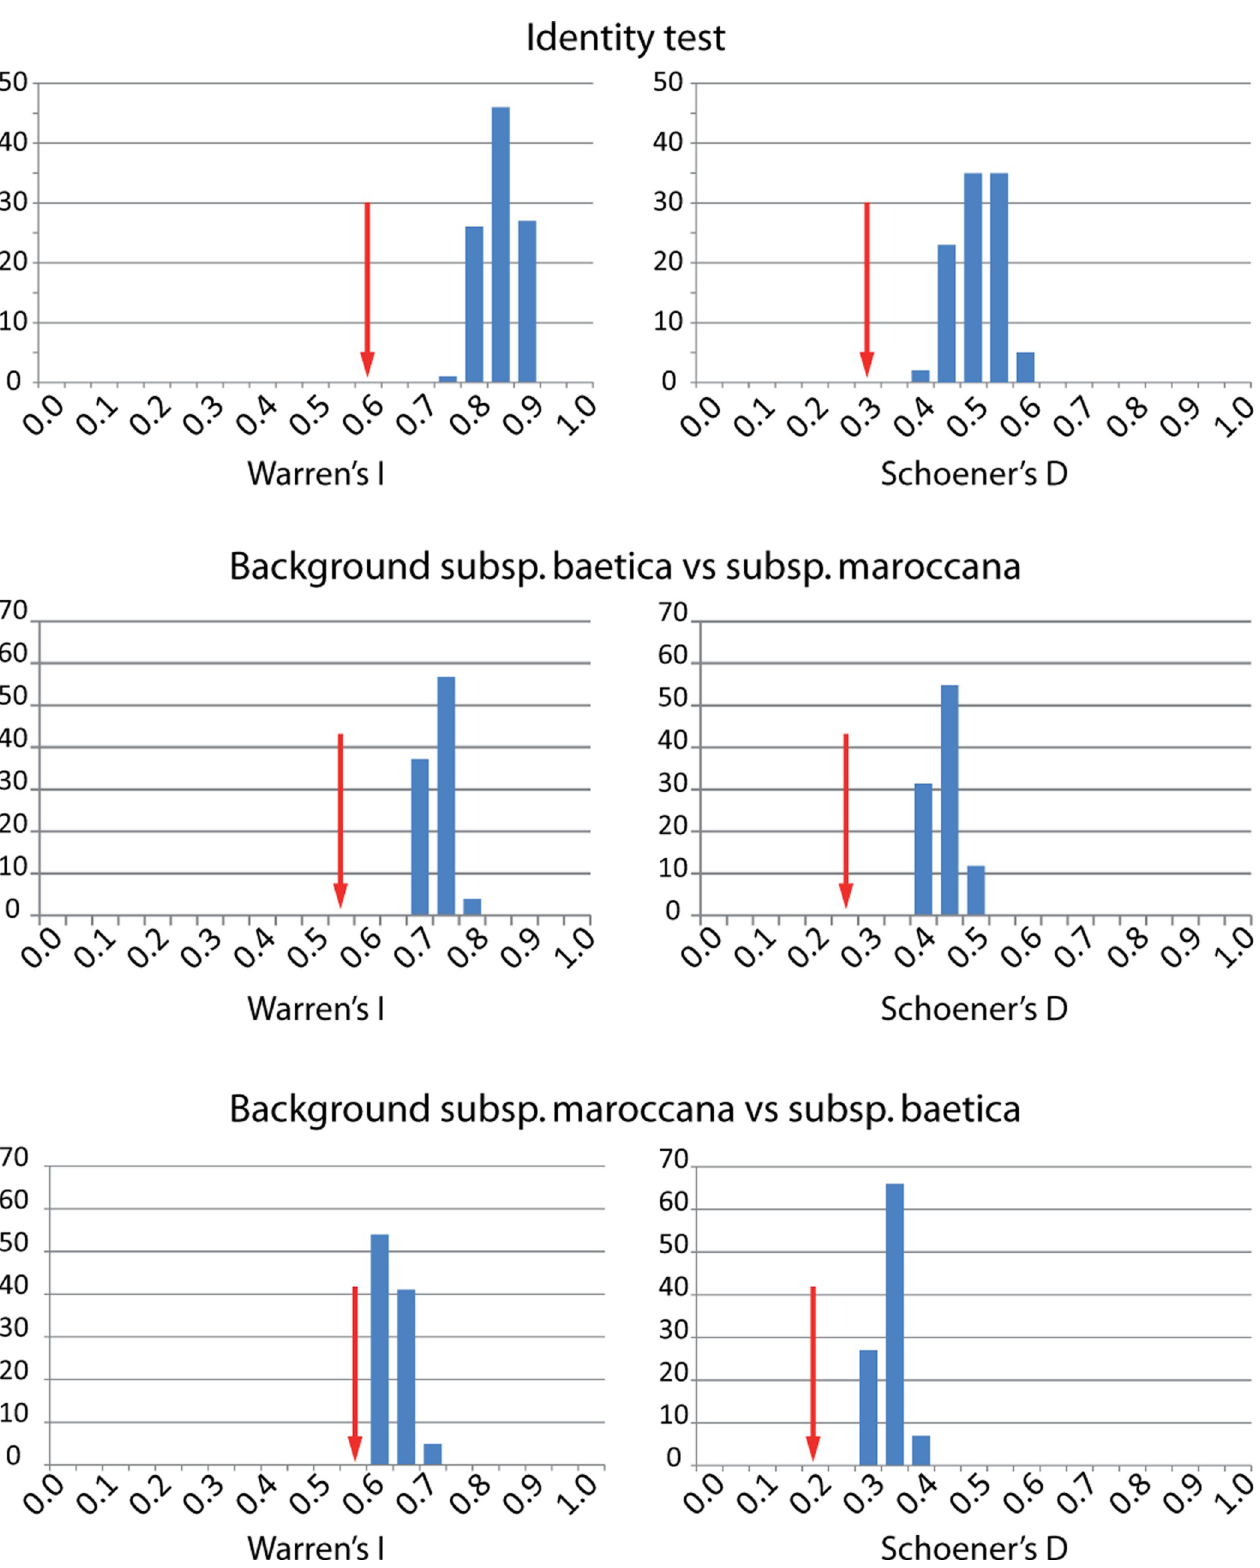
Fig 7. Observed niche overlap values for Hellinger-derived I and Schoener’s D indices compared with a null distribution. In all cases, the similarity score (red arrow) is less than that predicted by the null hypothesis for niche equivalency, indicating that the environmental niches are not equivalent.